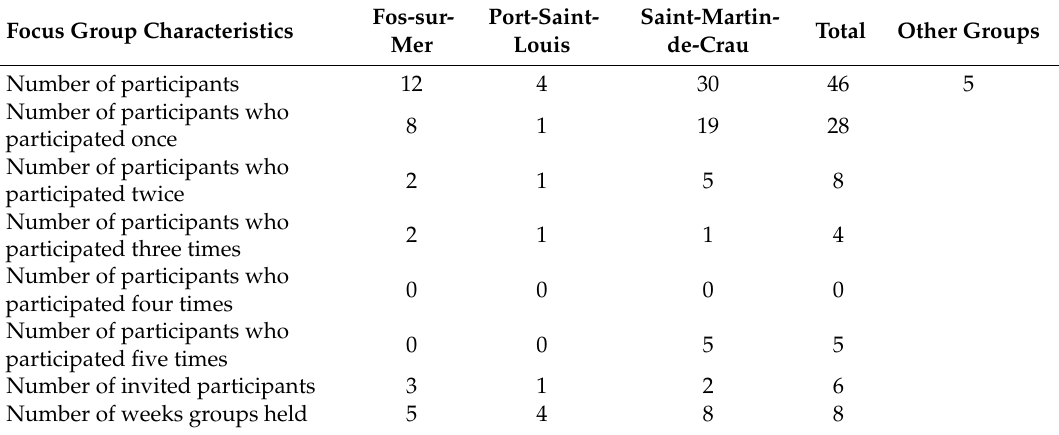
Table 2. Quantitative description of the iterative process of focus groups in phase 2 of Fos